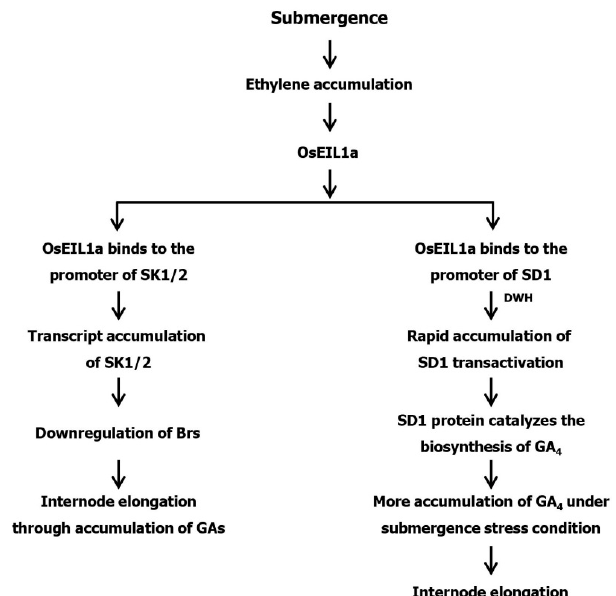
Figure 2. Proposed model for rice internode elongation under submergence stress conditions. Modified figure [13]. EIL1a binds with the both promoters of SK1/2 and SD1 in rice under submergence stress conditions. SK1/2 downregulates Brs that induce internode elongation through the accumulation of GAs. On the other hand, SD1 induces internode elongation through the accumulation of GA 4 . Brs: brassinosteroids; EIL1a: Ethylene Insensitive 3-like 1a; GA: Gibberellins; SD1: Semidwarf1; SK1/2: Snorkel 1/2.